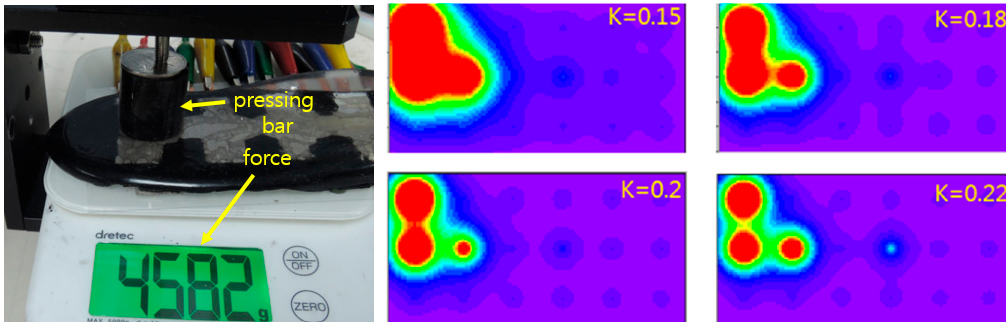
Figure 12. k’s characteristic test setup and pressure images with k values of 0.15, 0.18, 0.2 and 0.22 for 4.5 kgf force exerted on the left ‐ upper part of the insole.